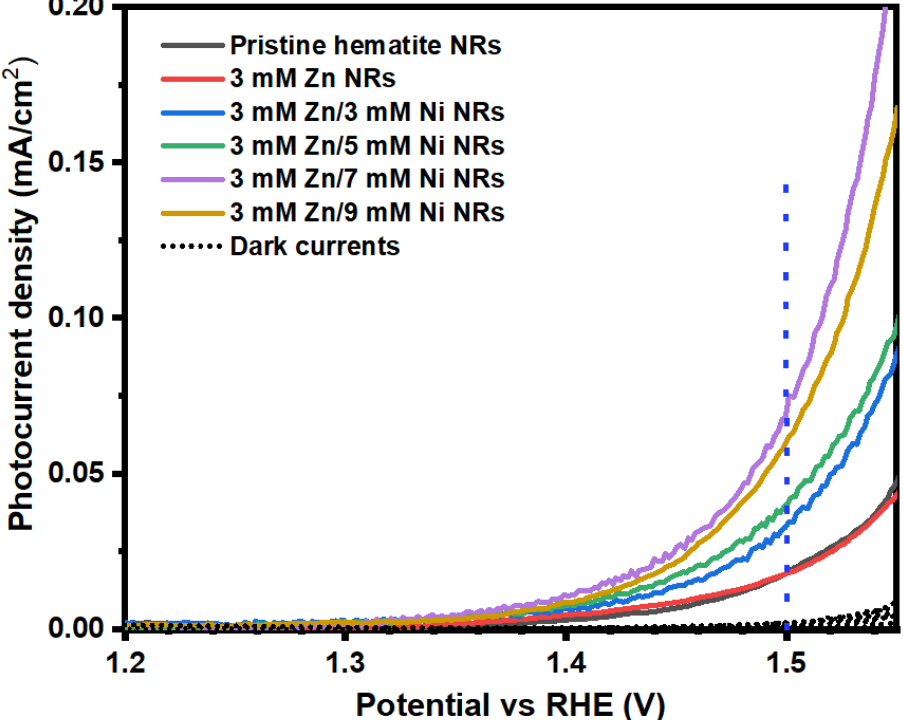
Figure 9. Photocurrent density plots of hematite NRs co-doped with different Zn/Ni concentrations.